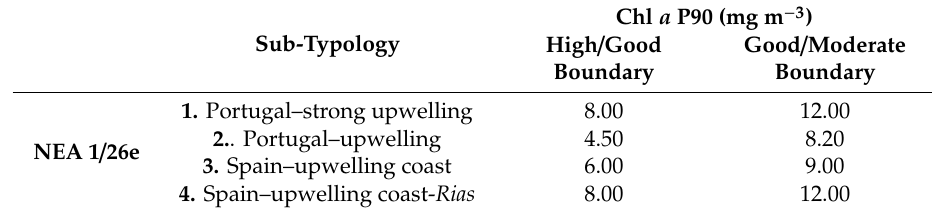
Table 3. High / Good and Good / Moderate boundary conditions, in terms of Chl a P90 (mg m − 3 ) for the four sub-typologies of the NEA 1 / 26e